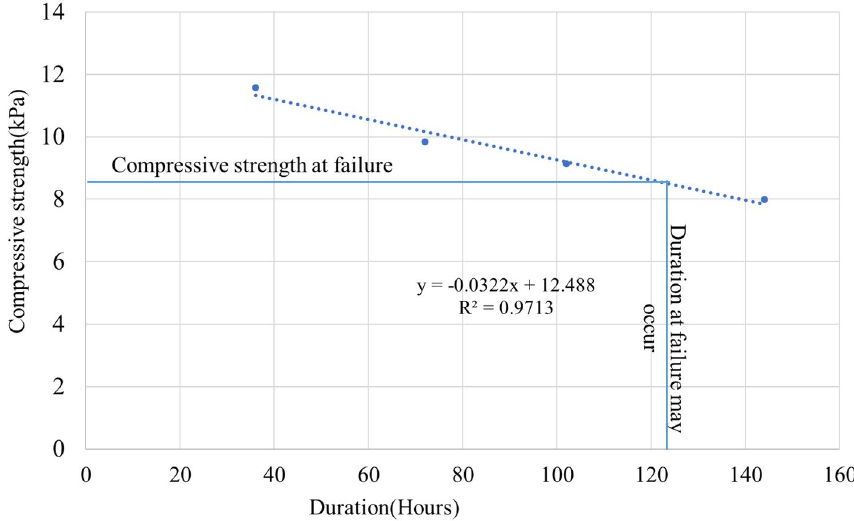
Figure 7. Compressive strength at different flood durations.